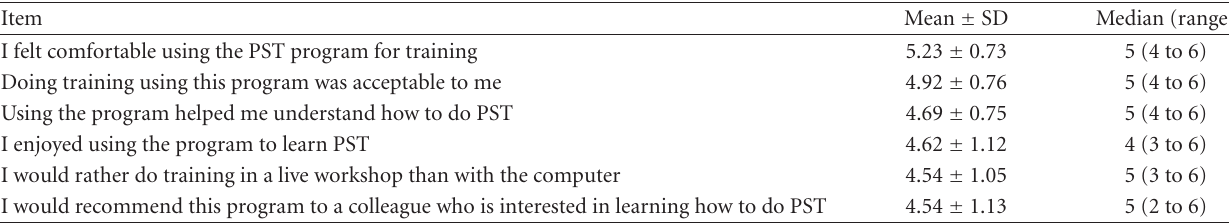
Table 2: Program Acceptability Questionnaire (scale range 0 to